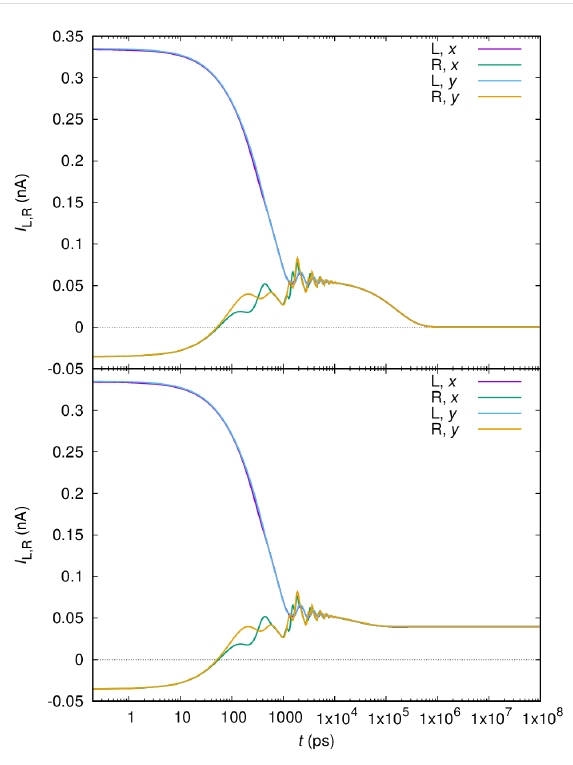
Figure 8: The current from the left lead (L) into the central system and the current from the central system into the right lead (R) for x - and y -polarized cavity photon field for the whole time range from the tran- sient to the steady state regime. The constant average photon number in the reservoir = 0 (upper), and = 1 (lower). g EM = 0.05 meV, = 0.343 meV, κ = 1.0 × 10 − 5 meV, B ext = 0.1